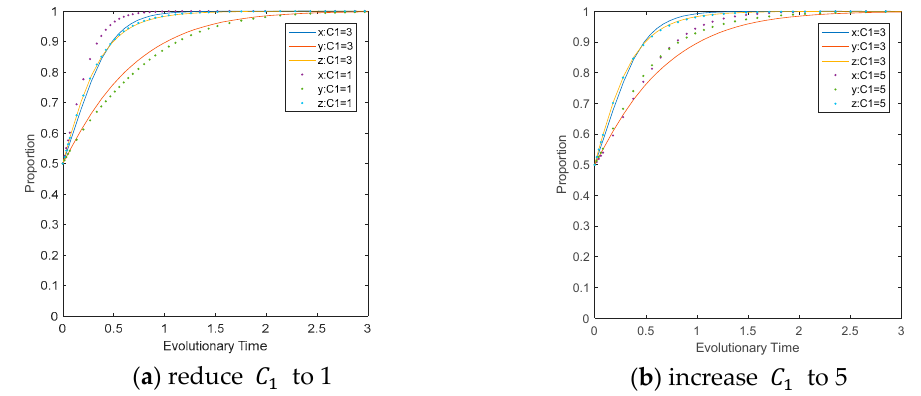
Figure 6. Impact of C 1 on the evolutionary path of multi-agents.